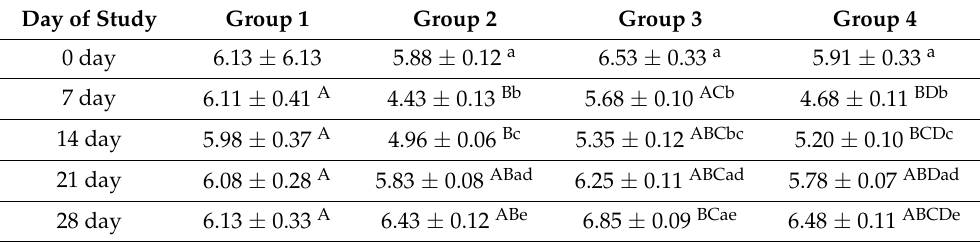
Table 3. Effect of adjuvanted, sonicated antigens on total erythrocyte count (million cells/cmm) in rabbits.